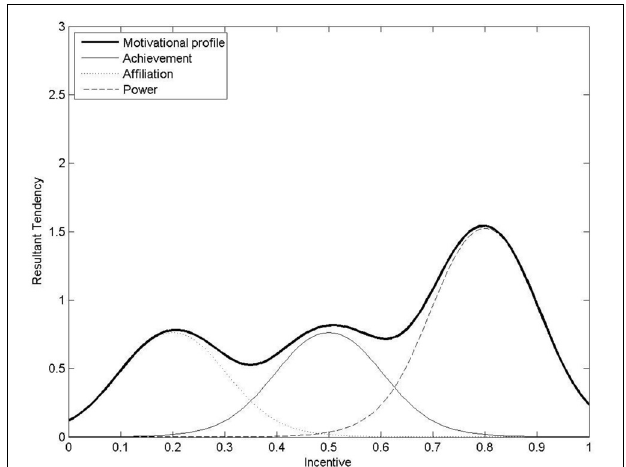
FIGURE 3 | A computational motive-profile as the sum of achievement, affiliation and power motivation. The resultant tendency for action is highest for incentive of 0.8 (the optimally motivating incentive for this agent). This agent may be qualitatively classified as “power-motivated” as its optimally motivating incentive is relatively high on the [0, 1] scale for incentive. Image from (Merrick and Shafi, 2011).